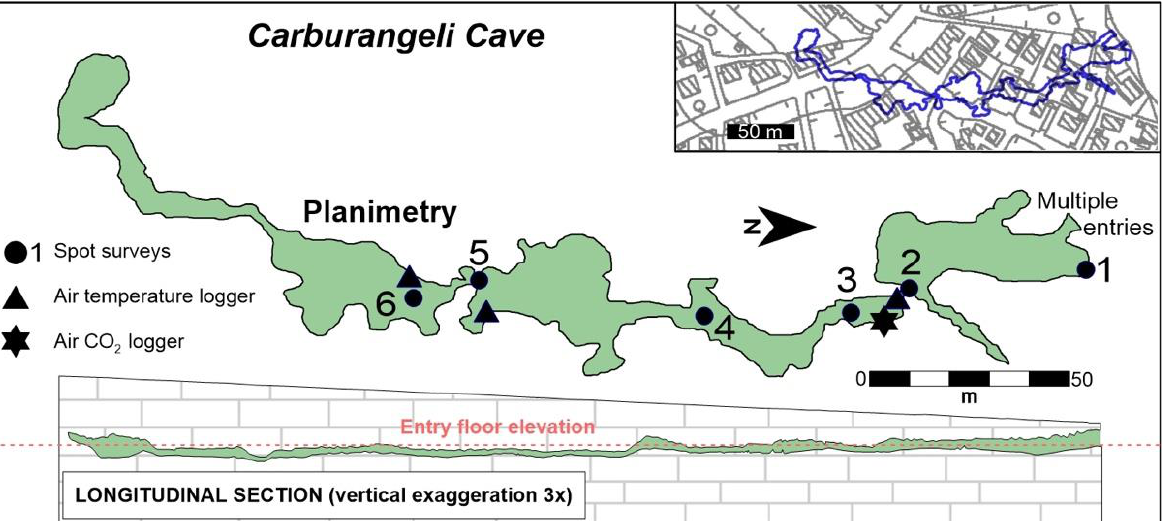
Figure 2. Planimetry and longitudinal section of the Carburangeli cave, with location of the points of measure (spot and quasi-real time); in the inset, surface projection of the area occupied by the cave.